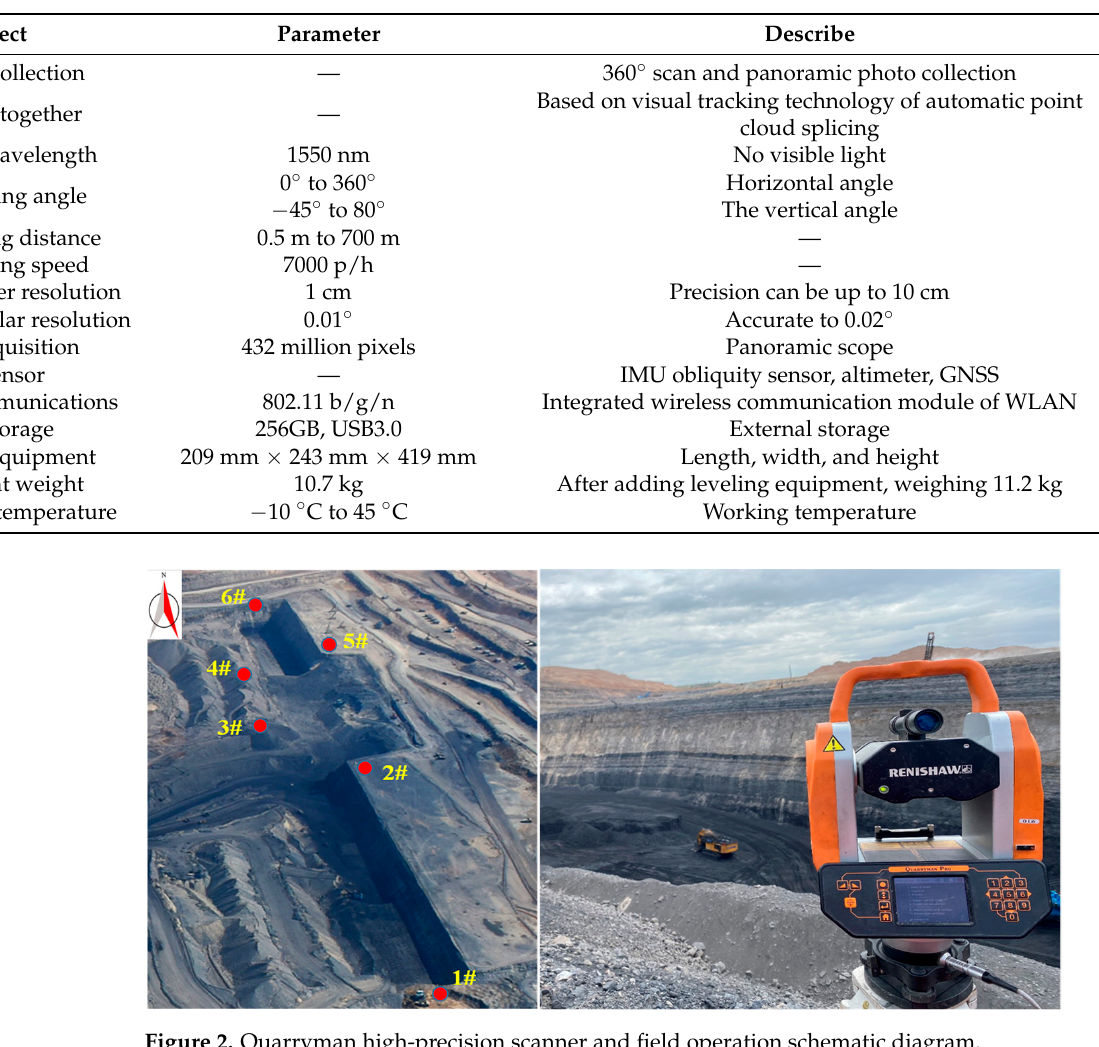
Figure 2. Quarryman high-precision scanner and field operation schematic diagram. Table 1. Quarryman high-precision scanner equipment parameters.